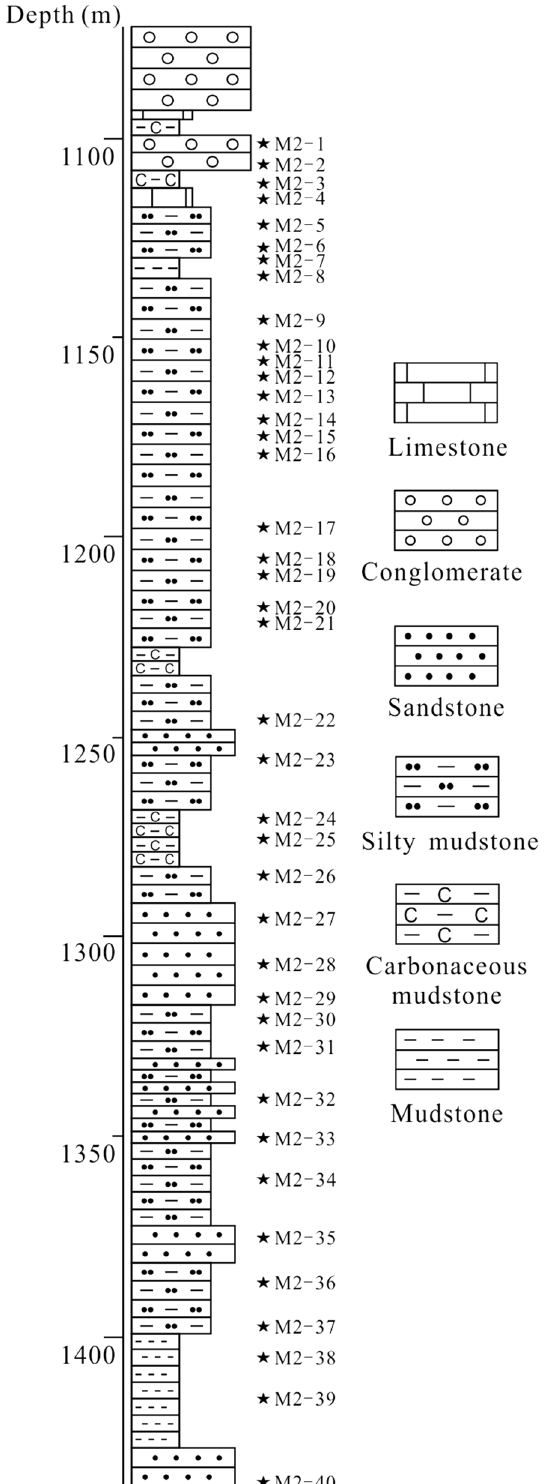
Figure 3. Stratigraphic column of the lower Zhoutian Formation in